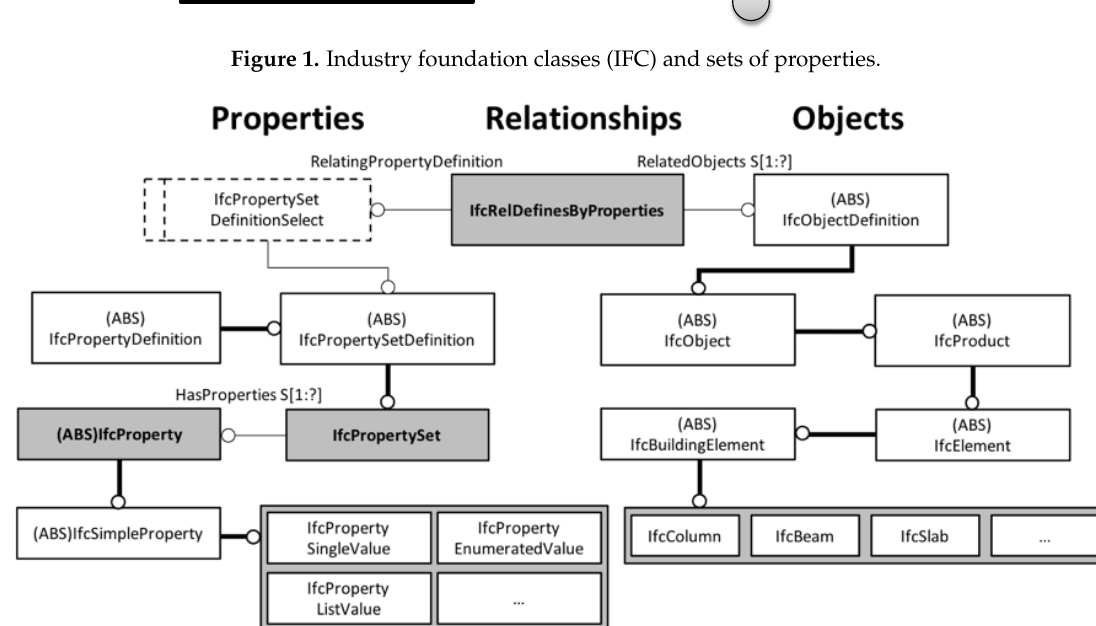
Figure 2. Object, property, and relationship in IFC architecture focused on IfcPropertySet.